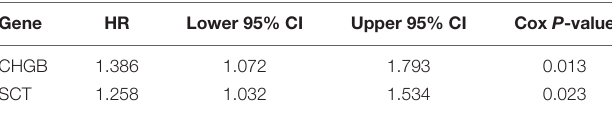
TABLE 5 | Univariate Cox regression